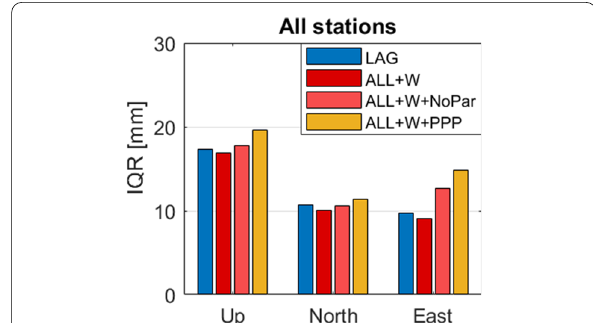
Fig. 14 Repeatability of estimated station coordinates by means of IQR for different constraining tests